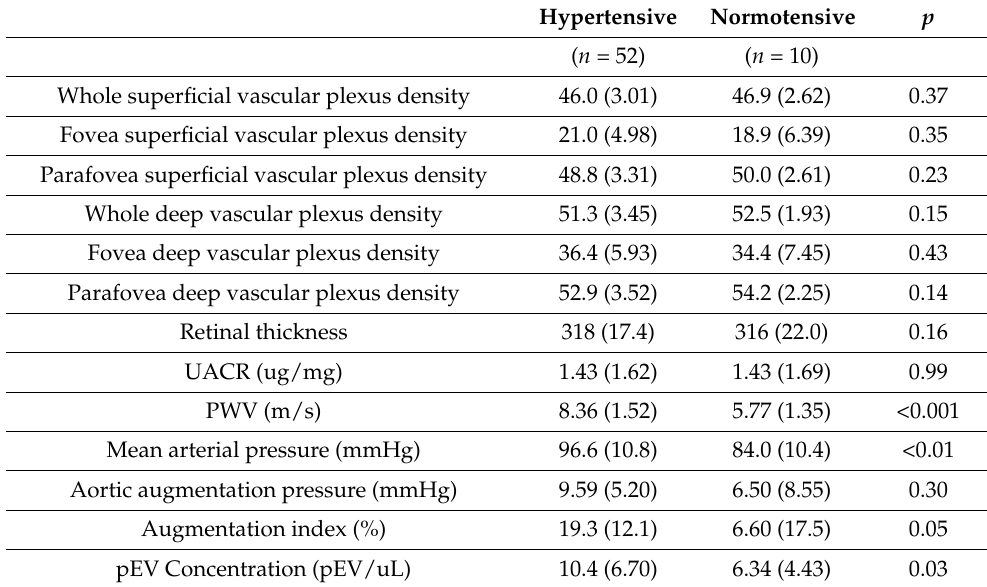
Table 2. Summary of the platelet derived extracellular vesicles, microvascular, and macrovascular damage comparisons between the normotensive and hypertensive